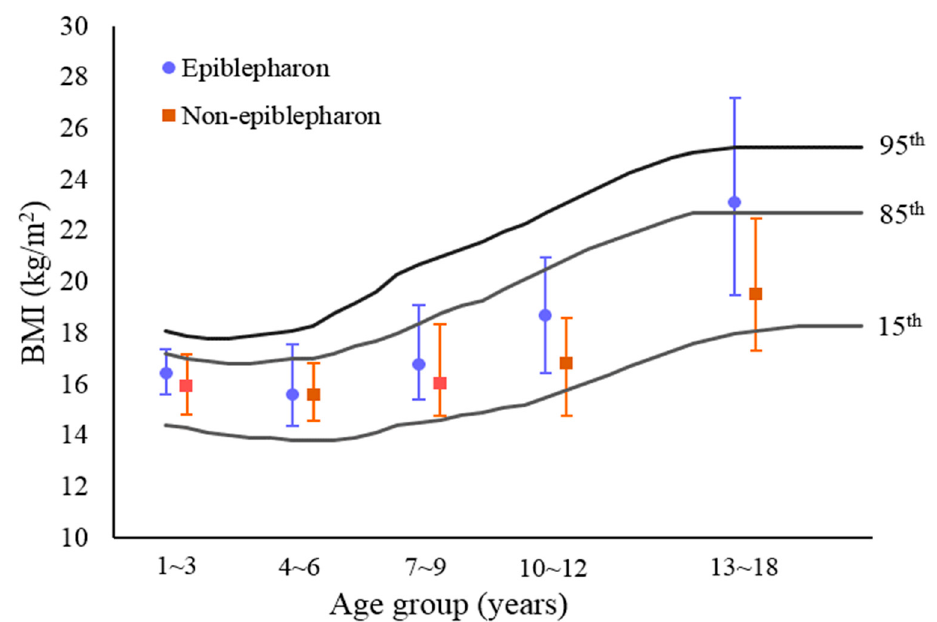
Figure 3. Comparison of body mass index (BMI) between epiblepharon and control groups (girls’ group). The background chart is the BMI-for-age growth curves by percentile, based on 2013 Taiwan standards.